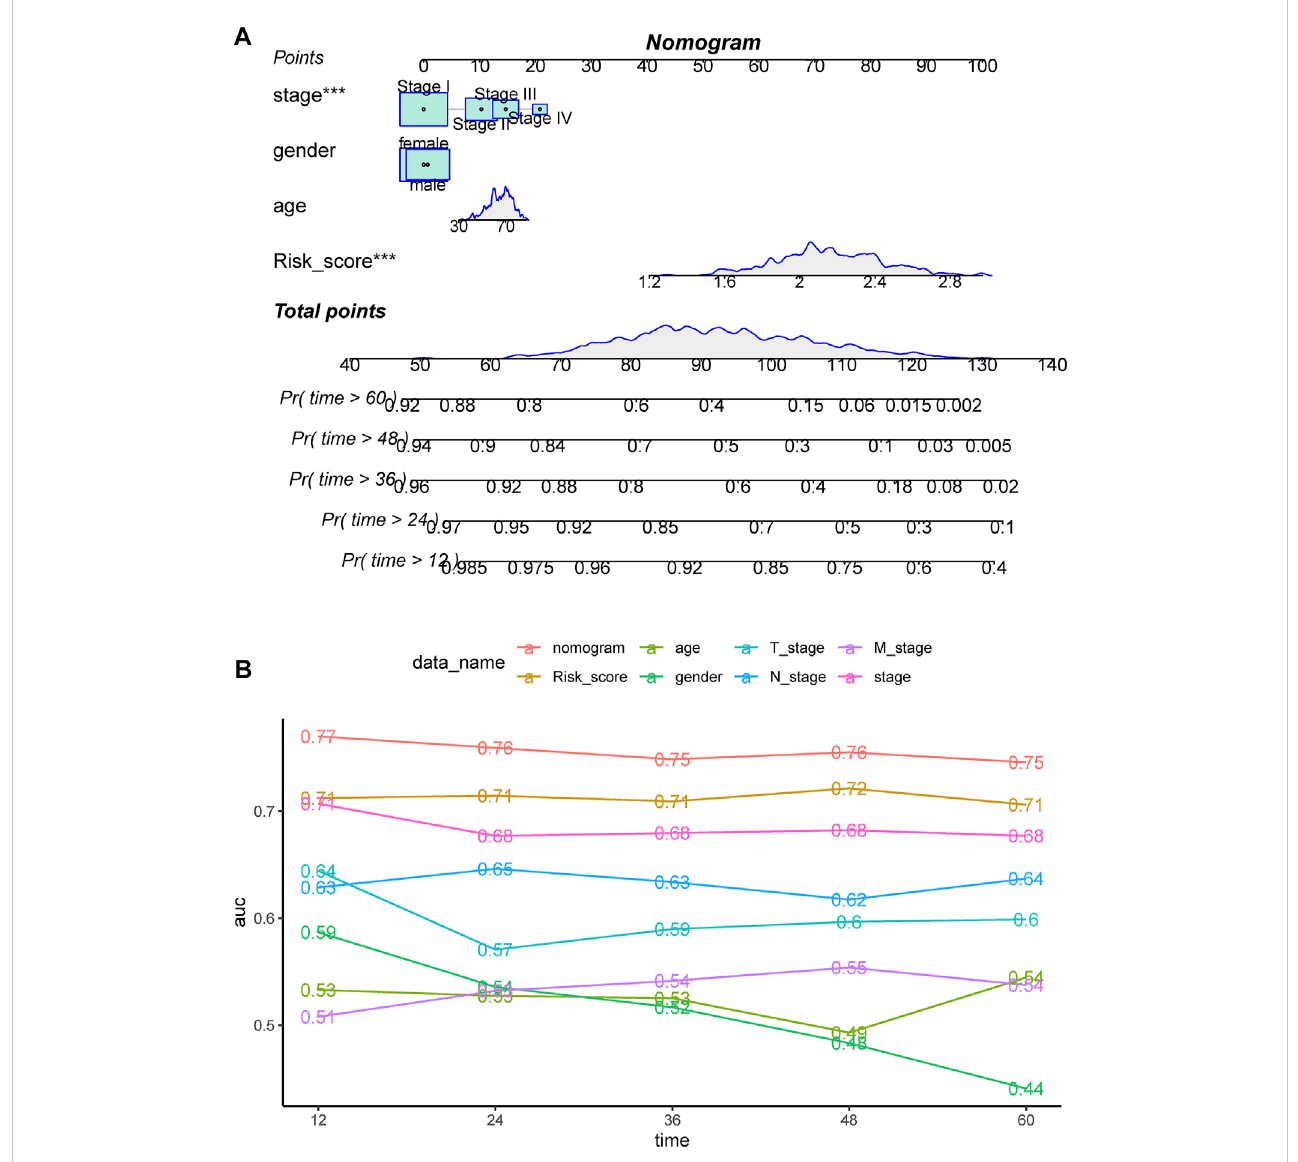
FIGURE 7 (A) Nomogramconstructed for predicting probabilities of 1-,3-, and 5-year overall survival (OS)in TCGAdataset by integrating therisk score and clinical factors, including stage, sex, and age. (B) ROC analyses of 1-, 3-, and 5-year OS for the nomogram and clinical